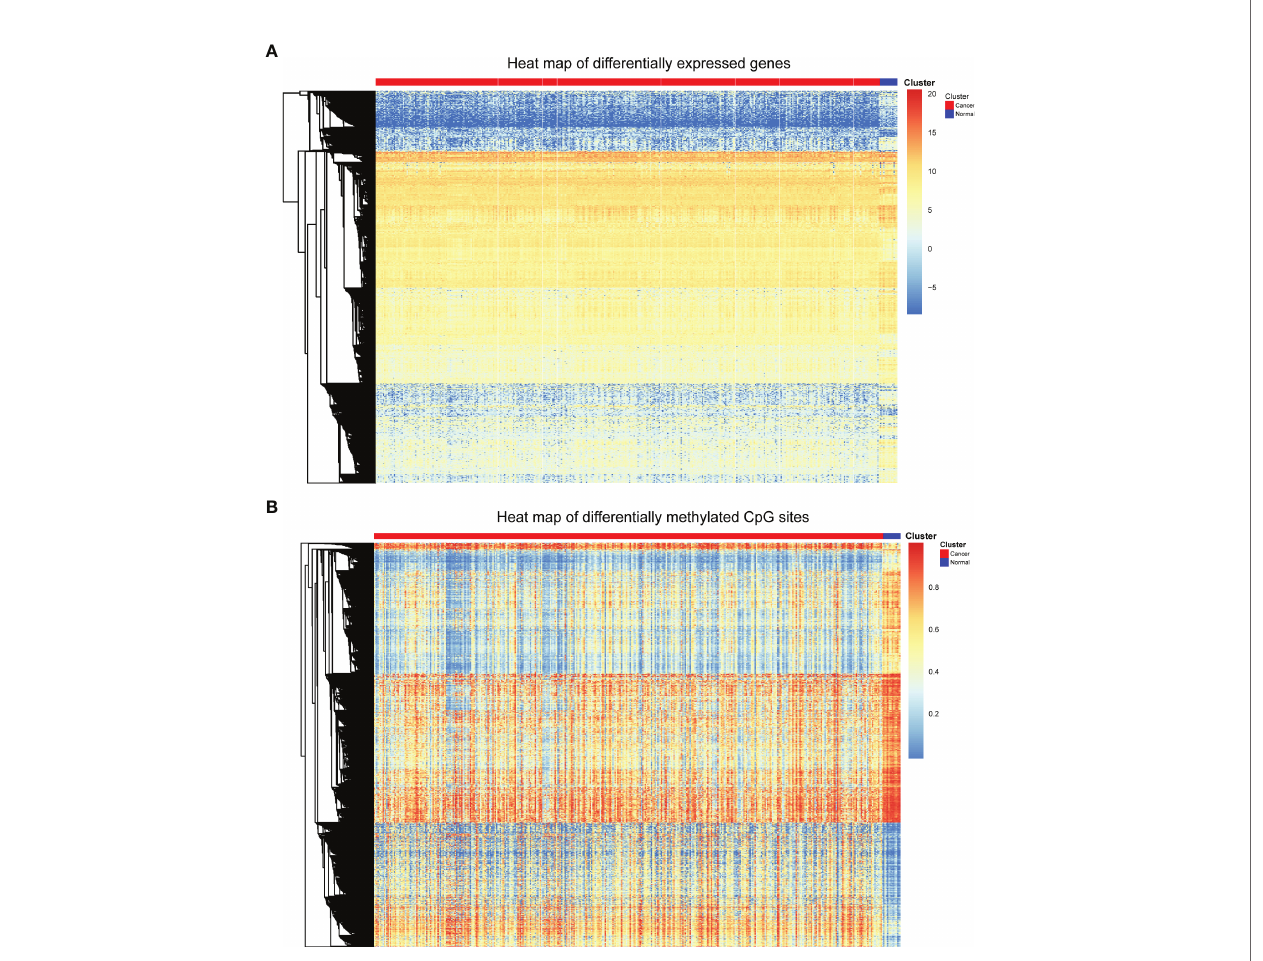
FIGURE 1 | Heat map of differentially expressed genes and differentially methylated CpGs. (A) Heat map of differentially expressed genes. (B) Heat map of differential methylated CpG